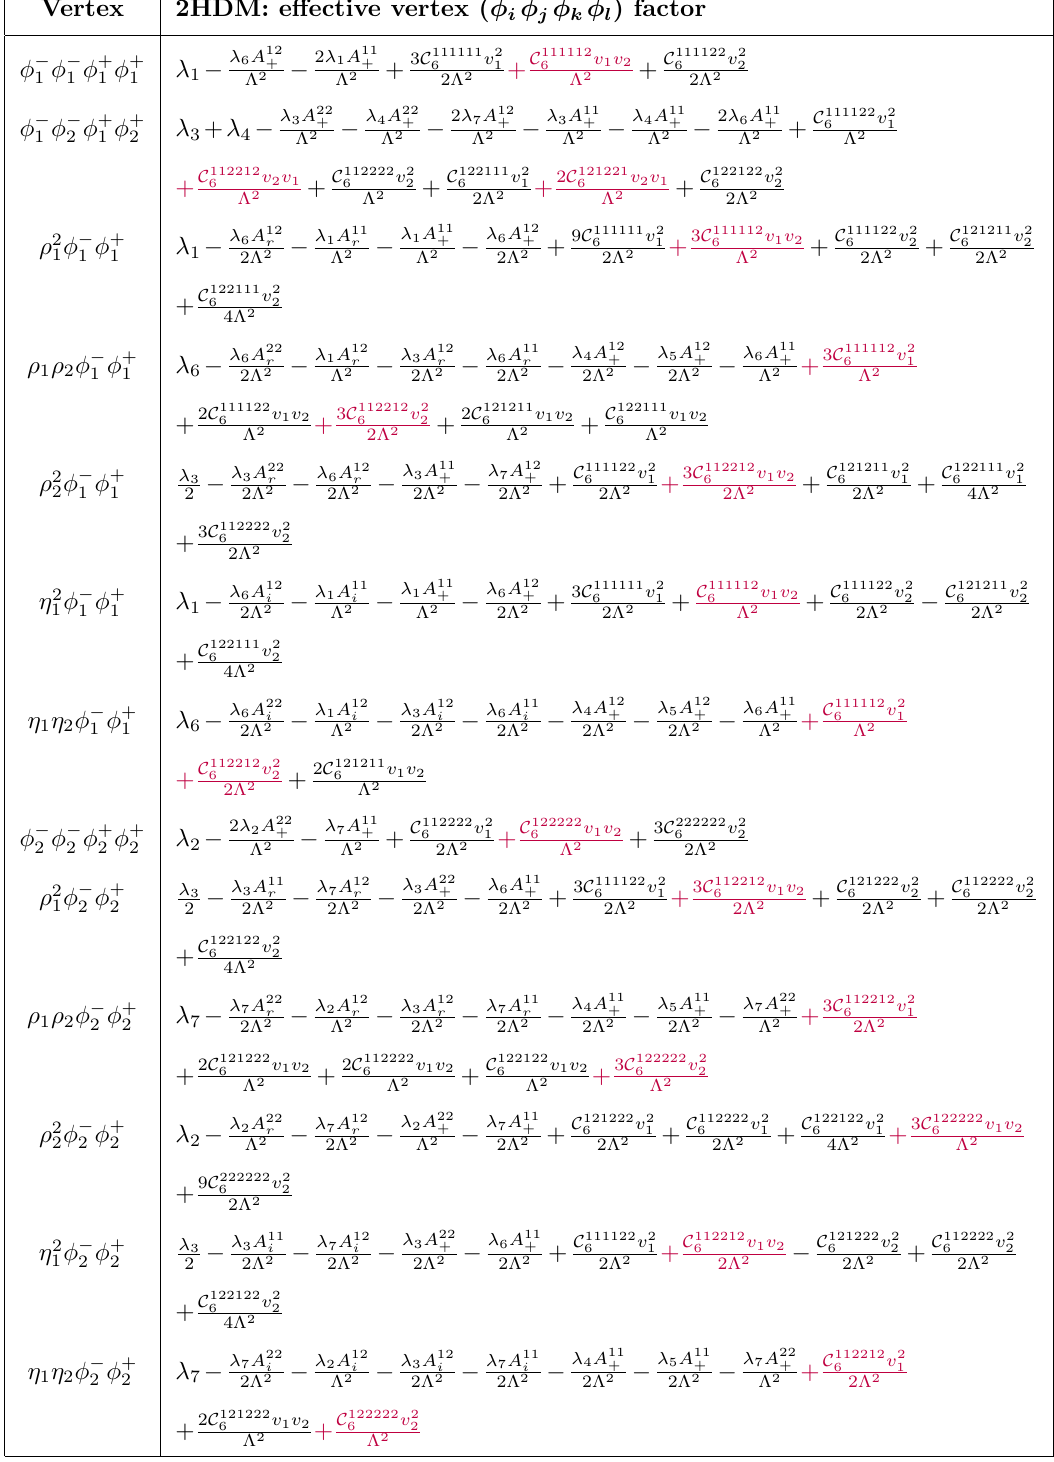
Table 47. 2HDM: scalar four-point vertices in the unphysical basis.